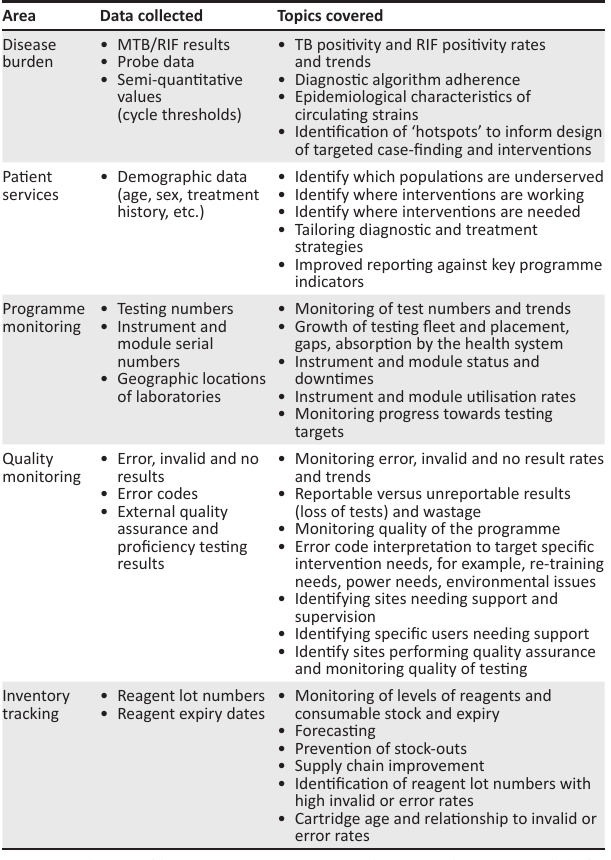
TABLE 1: Key topics covered during the 2018 TB Data Fellowship training.